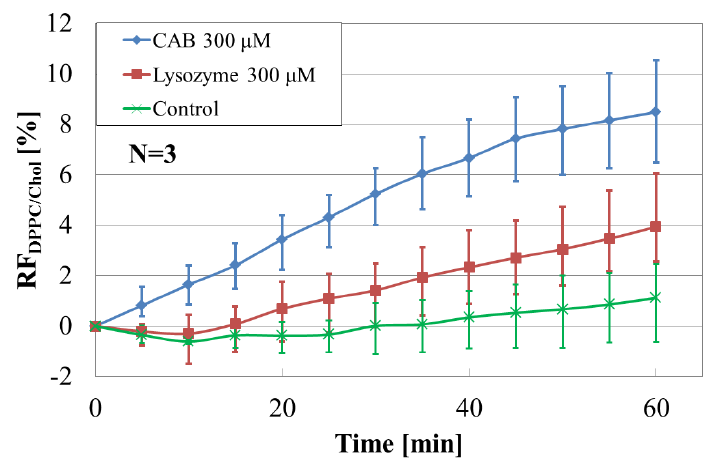
Figure 4. Time course of RF’s of DPPC/cholesterol added with different target proteins (300 μM) for 60 min, including the results of control sample without those proteins.